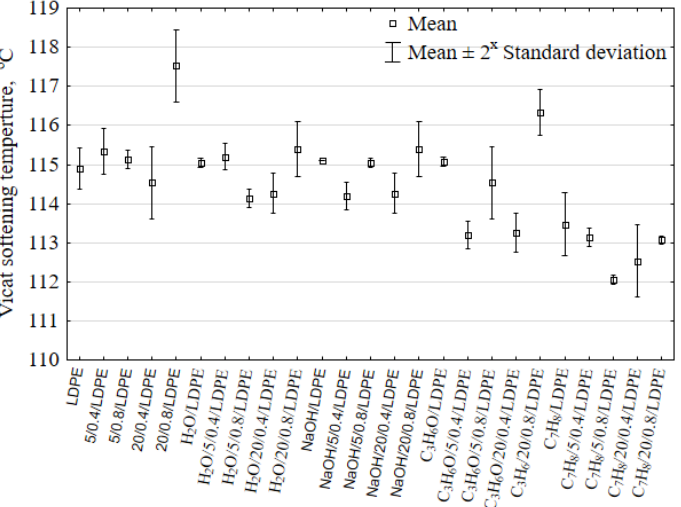
Figure 7. Vicat softening temperature of the selected samples of pure LDPE and LDPE with natural fillers versus different solvents.